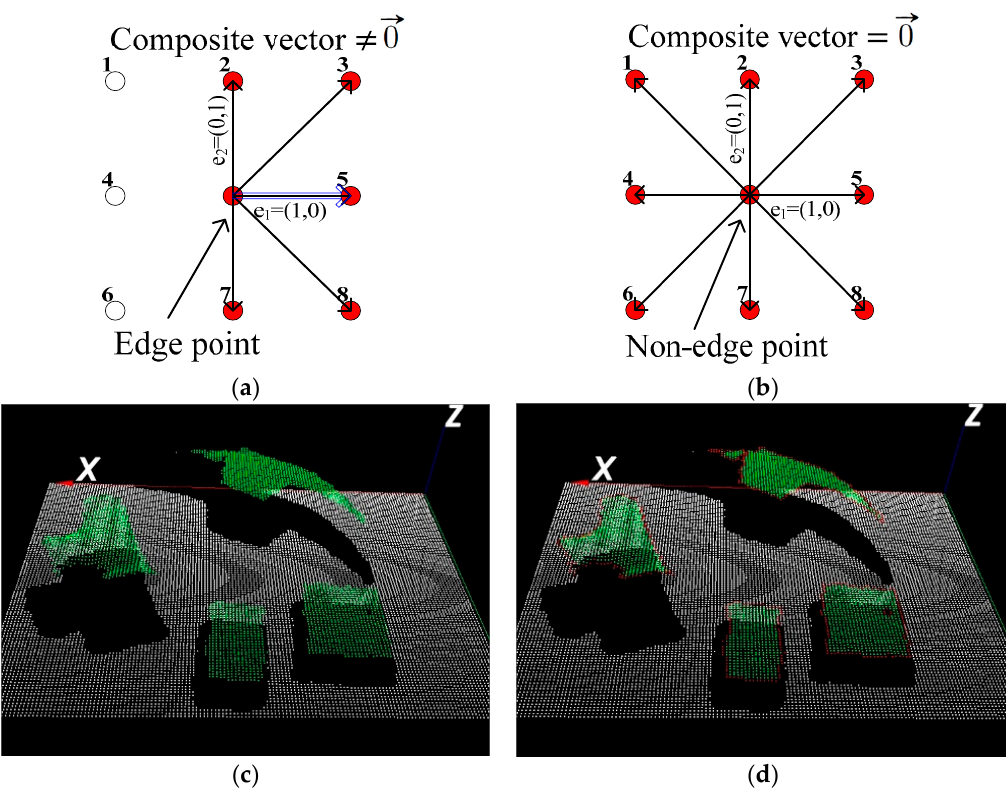
Figure 9. Estimation of initial edge point: ( a ) edge point, ( b ) non-edge point, ( c ) an example of the measured point cloud, and ( d ) an initial edge link established for the example in ( c ).